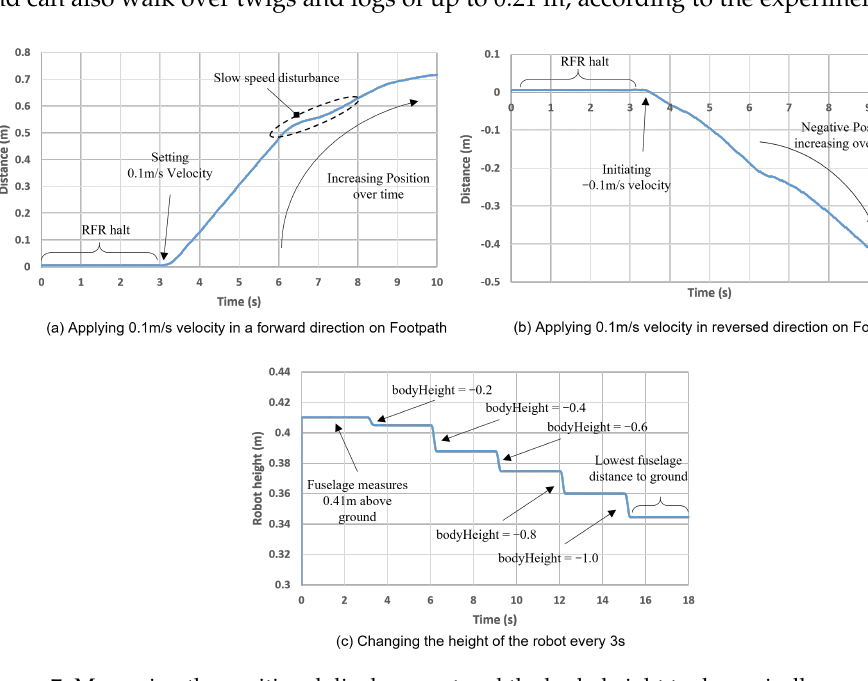
Figure 7. Measuring the positional displacement and the body height to dynamically manoeuvre in the